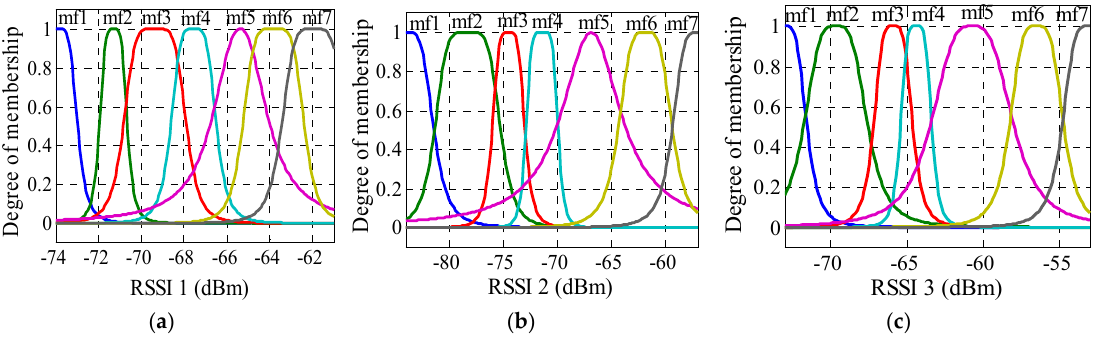
Figure 10. ANFIS seven gbellmfs input of outdoor velodrome ( a ) RSSI 1; ( b ) RSSI 2; and ( c ) RSSI 3.